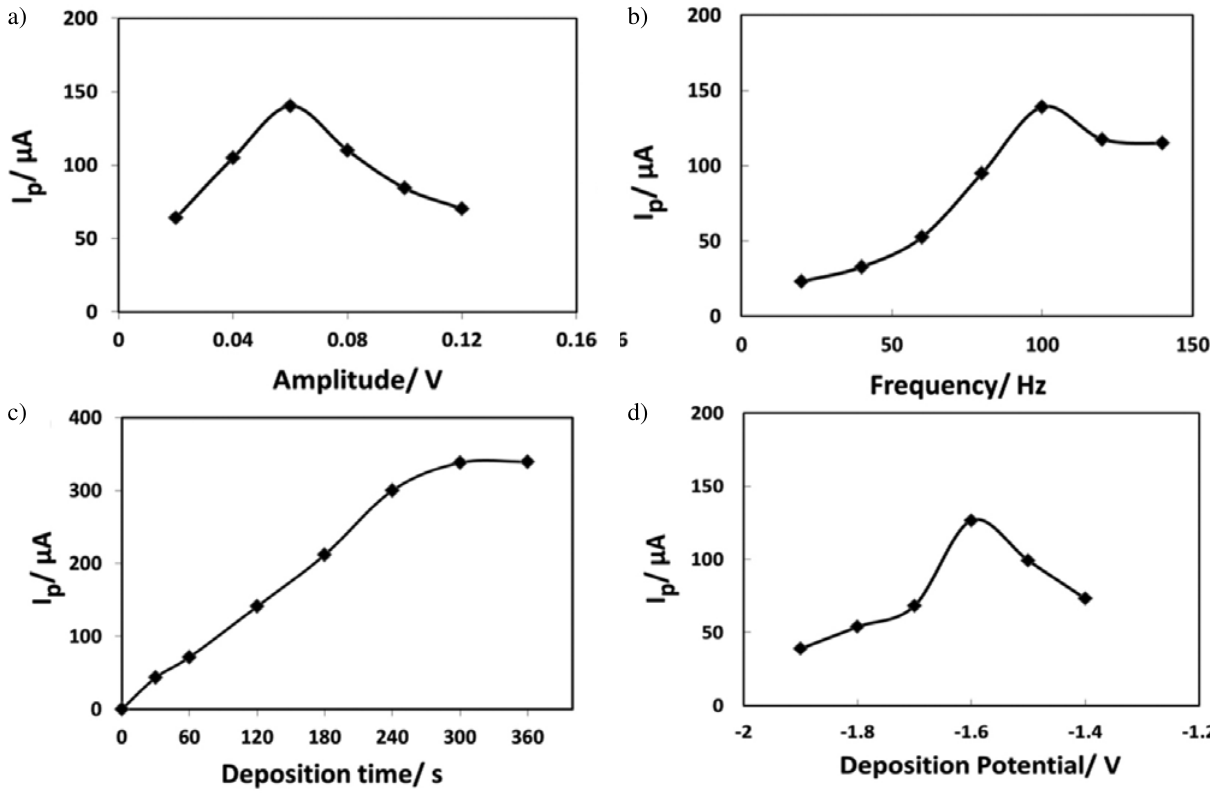
Figure 10: Plots of peak current vs. a) amplitude, b) frequency, c) deposition time, and d) deposition potential of the square wave voltammograms of 6.2 × 10 –7 mol/L Hg(II) solution in 0.1 mol/L acetate buffer (pH 5.5) at GPE surfaces. Other conditions are identical to those described in Fig. 2a.